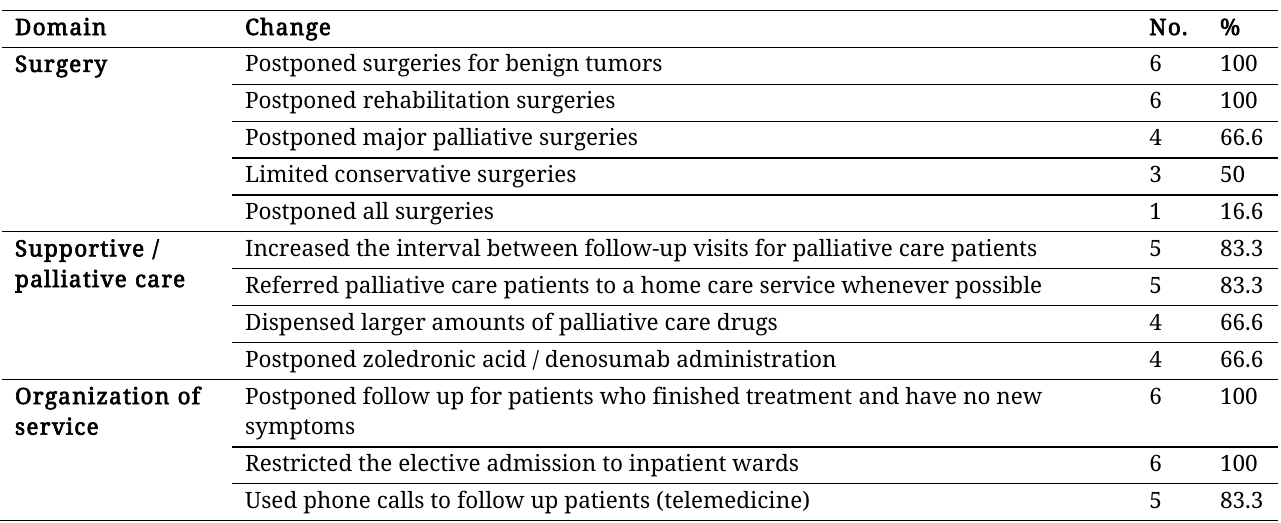
Table 3: Practice changes related to surgery, supportive/palliative care and organization of